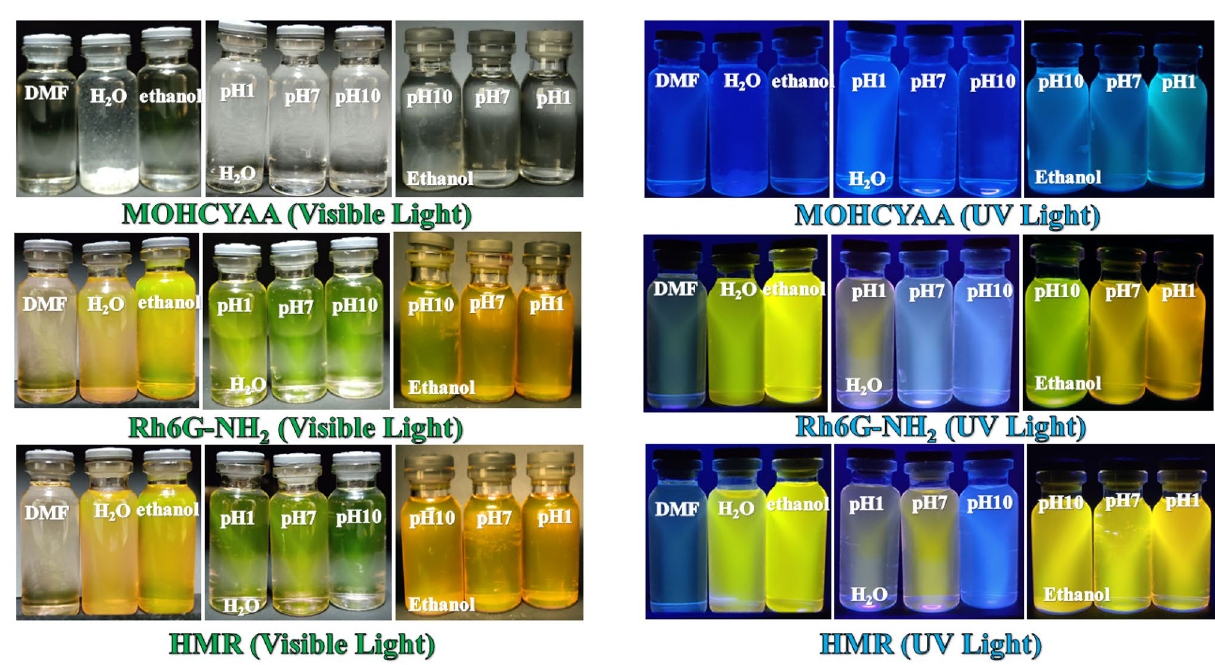
Figure 7. Solution of MOHCYAA, Rh6G-NH 2, and HMR in various